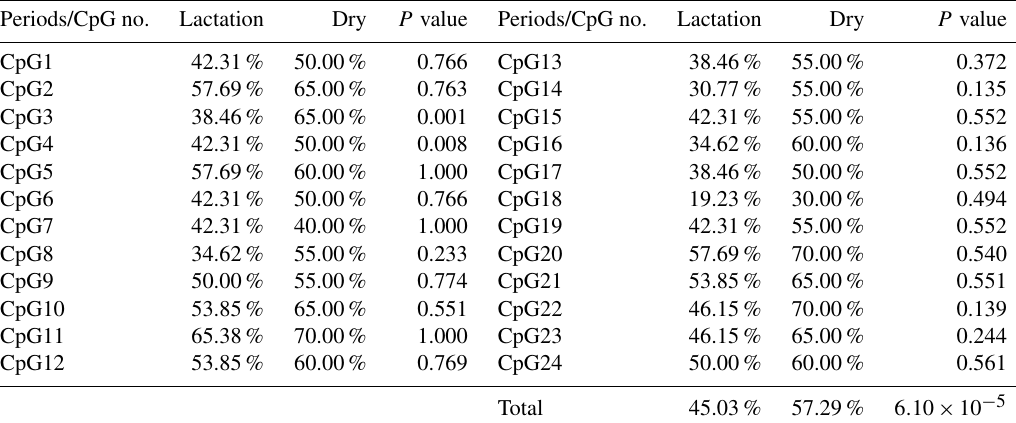
Table 4. Methylation percentage and P value difference for each CpG-dinucleotide locus between the mammary gland tissue from the dry and lactation